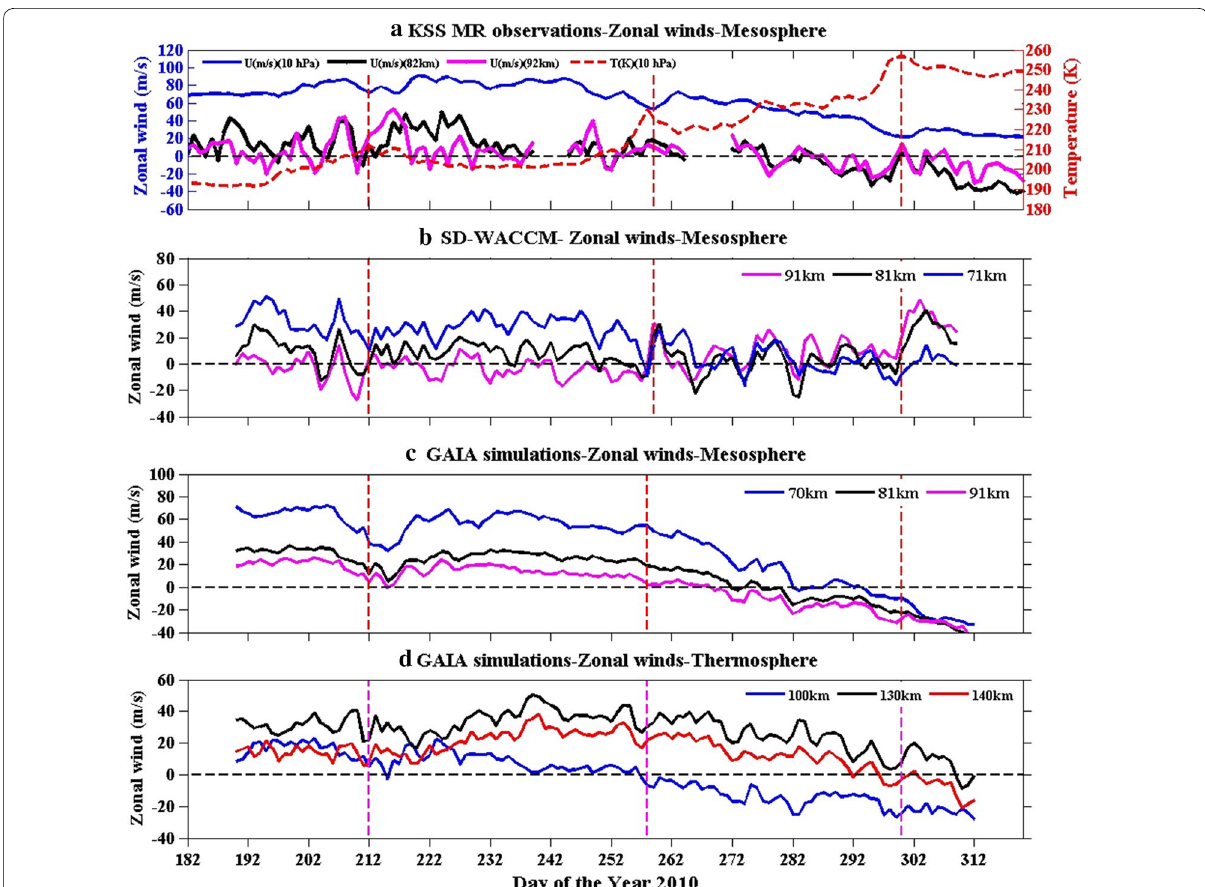
Fig. 2 a Zonal mean zonal winds ( blue line ) and zonal mean temperatures ( red dashed line ) at 10 hPa, same as in Fig. 1a. Zonal winds observed at 82 km ( black line ) and 92 km ( magenta line ) using KSS MR data. b SD-WACCM simulations of zonal mean zonal winds at 60°S for the altitudes 71, 81 and 91 km. c Same as b but using GAIA simulations at 70, 81 and 91 km. d GAIA simulations of lower thermospheric zonal winds at 100, 130 and 140 km. The dashed vertical lines indicate the days of peak